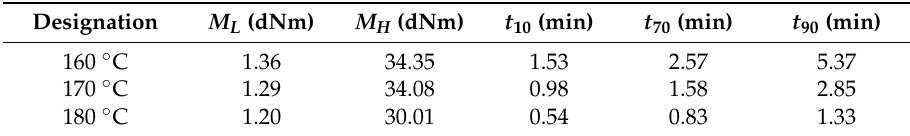
Table 2. Curing parameters of the MR at 160, 170, and 180 °C.